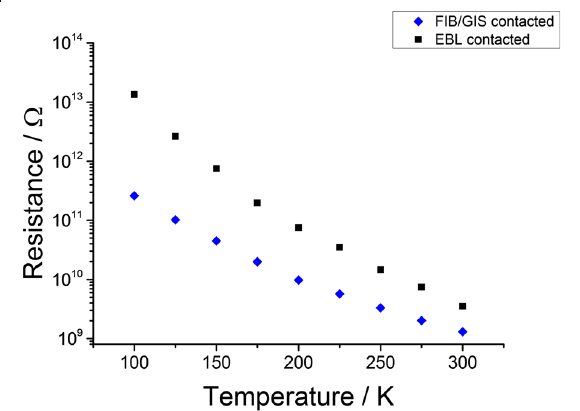
Fig. 6 Resistances of 4.0- μ m long SiNWs wired with FIB/GIS method compared with a 1.0-m long SiNW wired with the EBL method as a function of the temperature. The resistances are calculated by means of a linear fit in the voltage range of 4.8 5.0 V. The small difference in resistance observable at higher temperature could be attributed to a discrepancy on the effective lengths. However, at lower temperature, this difference becomes bigger up to one order of magnitude. We believe this finding could be the sign of a greater Schottky barrier in the EBL wired